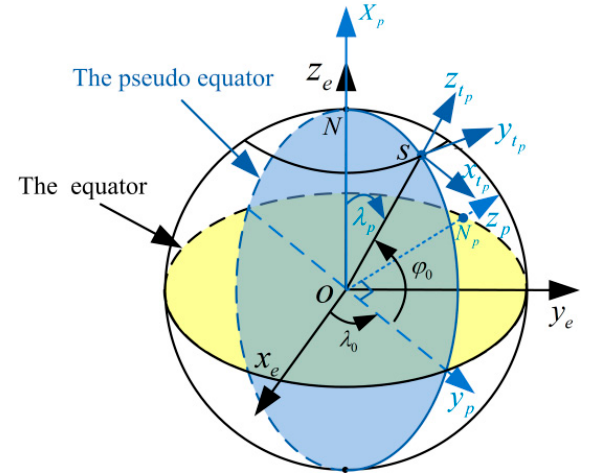
Figure 1. The pseudo-coordinate system.